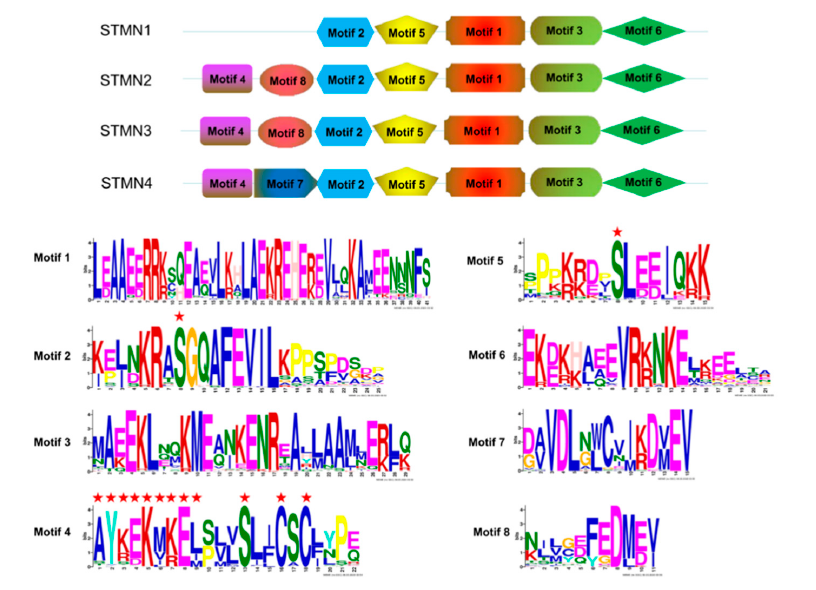
Figure 3. Di ff erent motif composition and distribution of the stathmin proteins. The height of a letter indicates its relative frequency at the given position for the amino acid. Eight conserved motifs are shown here. Some key residues are marked with